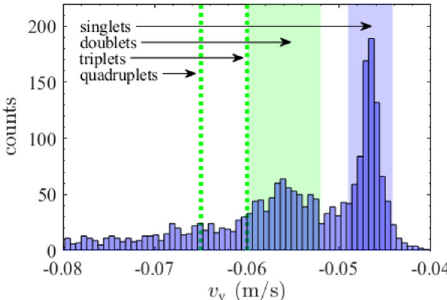
Fig. 1 Vertical velocity distribution. Histogram of the measured vertical velocity of all detected particles. The green band indicates the reported literature values of doublet velocities (see Table 1), which perfectly match the doublet peak observed in the velocity distribution. The green dotted lines show the predicted average vertical velocities of the triangular triplets and tetrahedral quadruplets. The blue band indicates the selected velocity range of the singlets. Table 1 Particle parameters and the resulting vertical velocity.